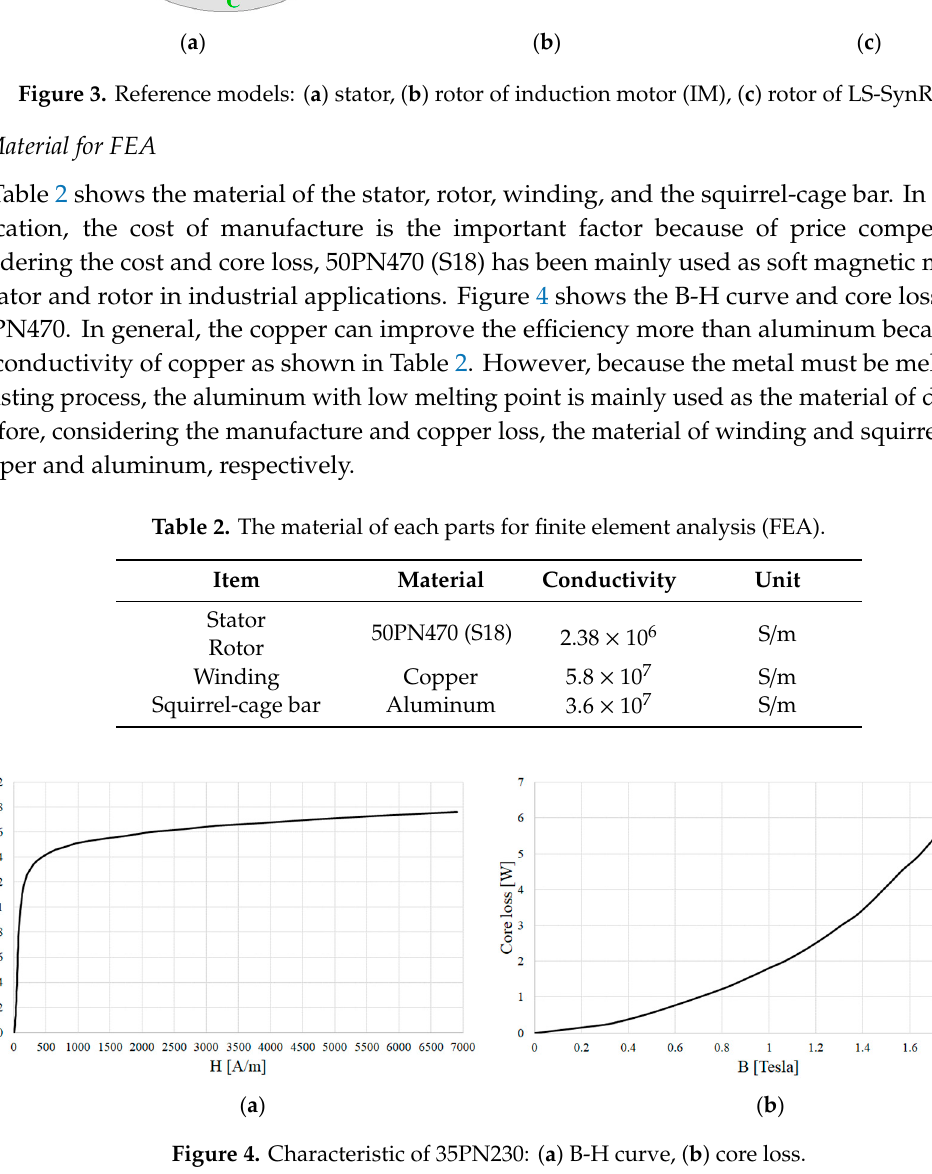
Figure 4. Characteristic of 35PN230: ( a ) B-H curve, ( b ) core loss.